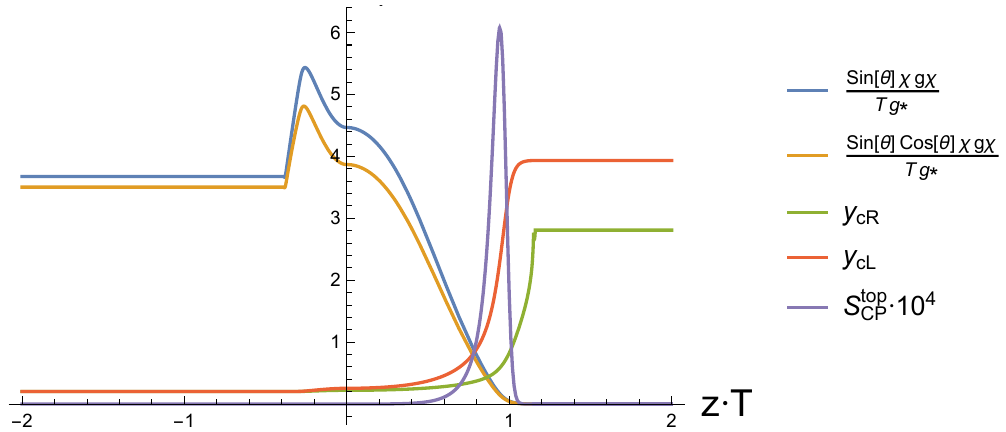
Figure 9 . Typical pro(cid:12)les (here for a meson-like dilaton with mass m (cid:31) = 500 GeV and N = 5) along the direction z perpendicular to the bubble wall of various dimensionless functions which are relevant for the produced baryon asymmetry assuming the (cid:13)avour structure discussed in section 6.4: in blue, the quantity which sets the gauge boson masses and the fermion masses in non-minimal composite Higgs models normalized to the nucleation temperature T n (see section 3.4); in yellow, the quantity which sets the fermion masses in minimal composite Higgs models normalized to the nucleation temperature; in green and red, the two charm mixings; in purple, the CP-violating force normalized to the nucleation temperature (see section